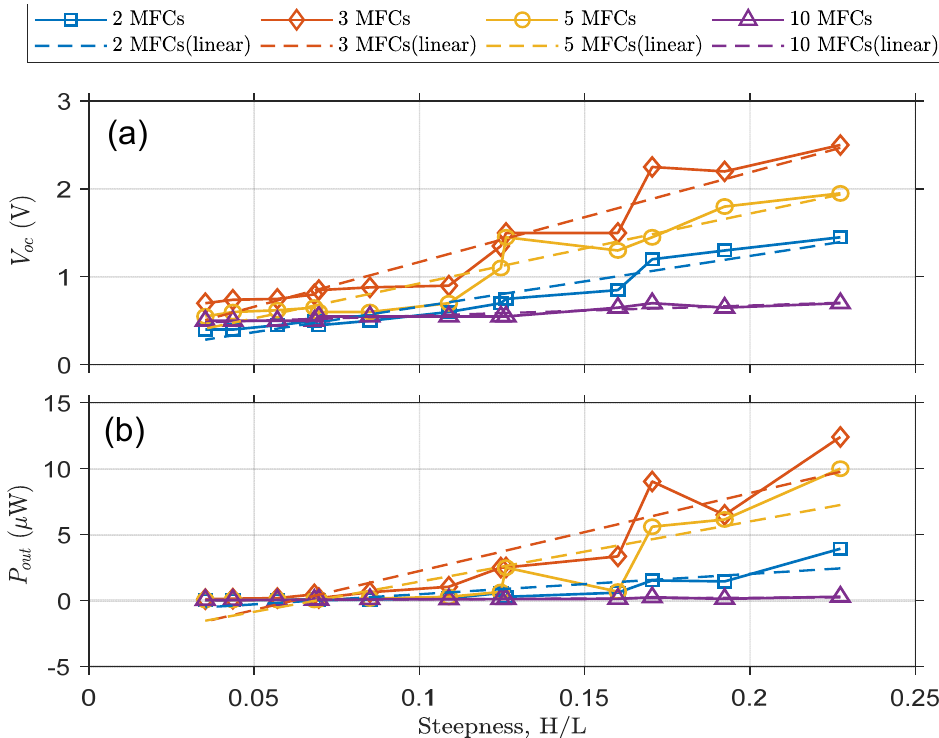
Figure 9. V OC and P OUT versus wave steepness for a OWECs with varying numbers of MFCs. ( a ) Output voltage versus wave steepness ( b ) Output power versus wave steepness.